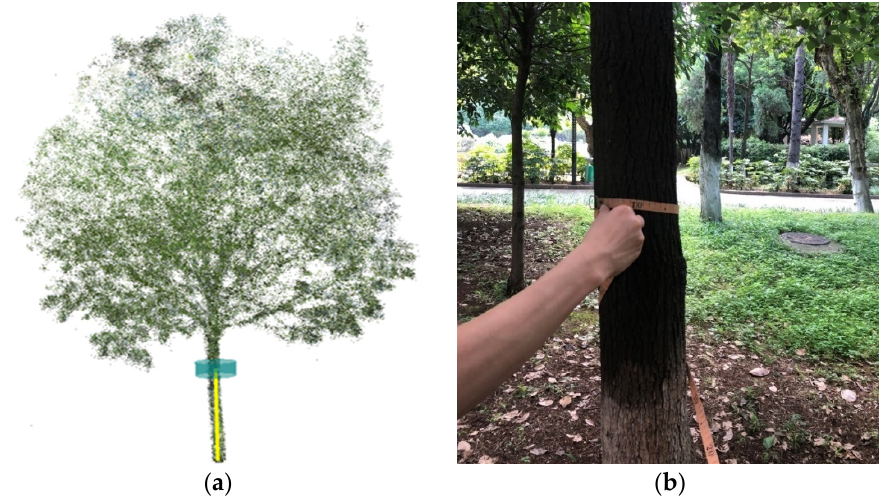
Figure 17. Single wood information diagram of different methods. (( a ) shows laser slam single wood point clouds; ( b ) shows manual measurement diagram).